Question: Looking at the figure, what chart type is it?
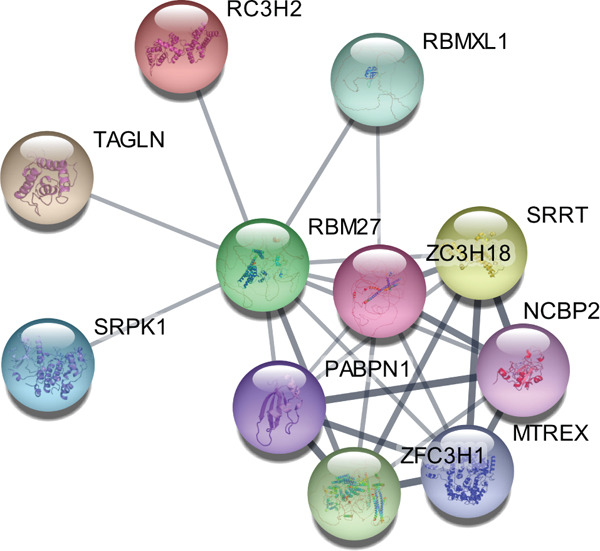
Answer: heatmap